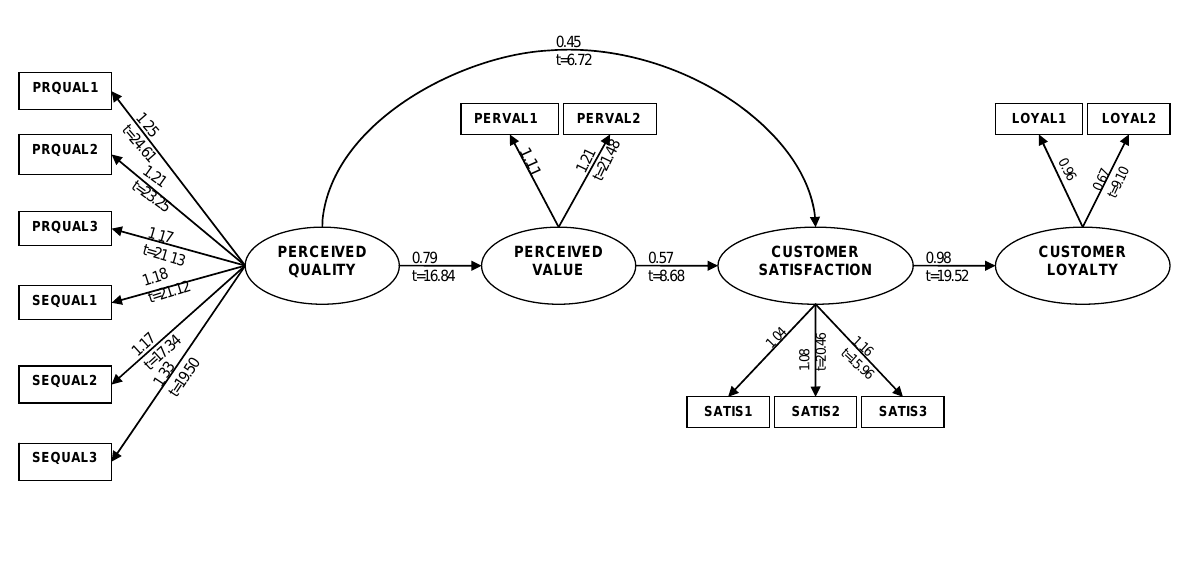
Figure 1: Empirical